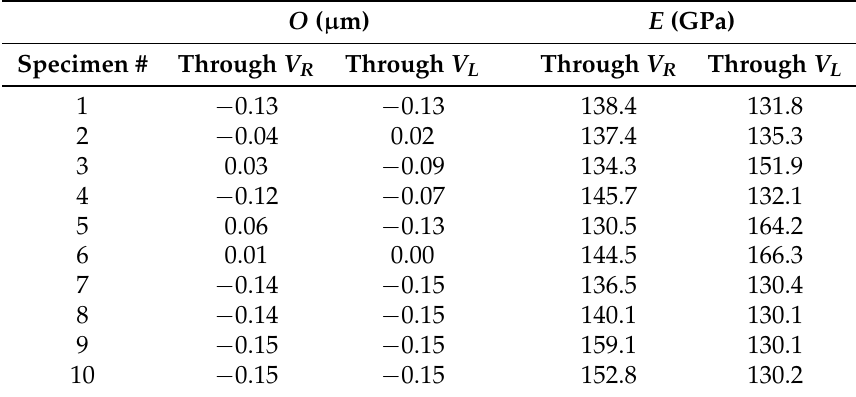
Table 2. Estimated parameter values through particle